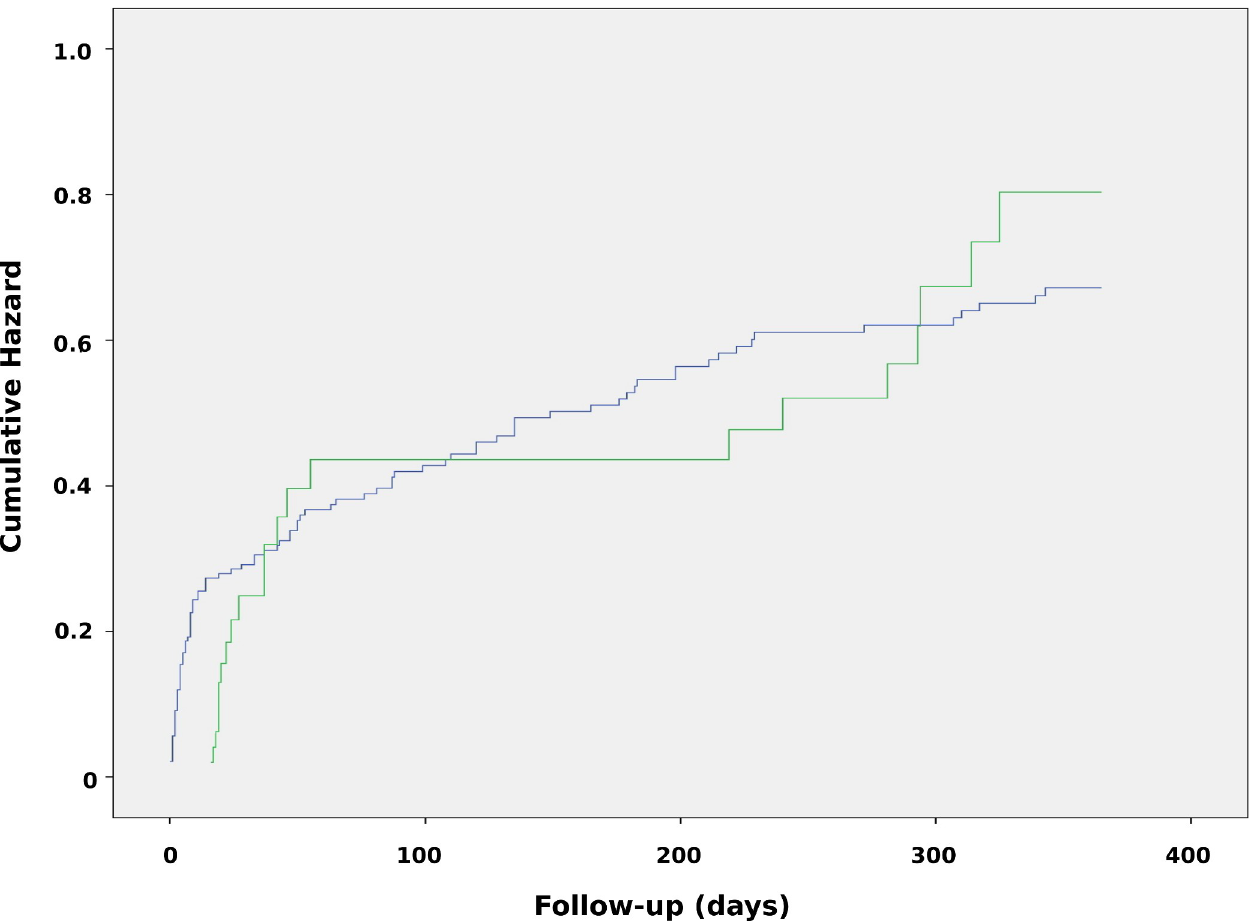
Fig 2. Adjusted cumulative hazard plot by treatment group in patients with pulmonary Pseudomonas aeruginosa . Green line: adequate antibiotic treatment. Blue line: non-adequate antibiotic treatment.